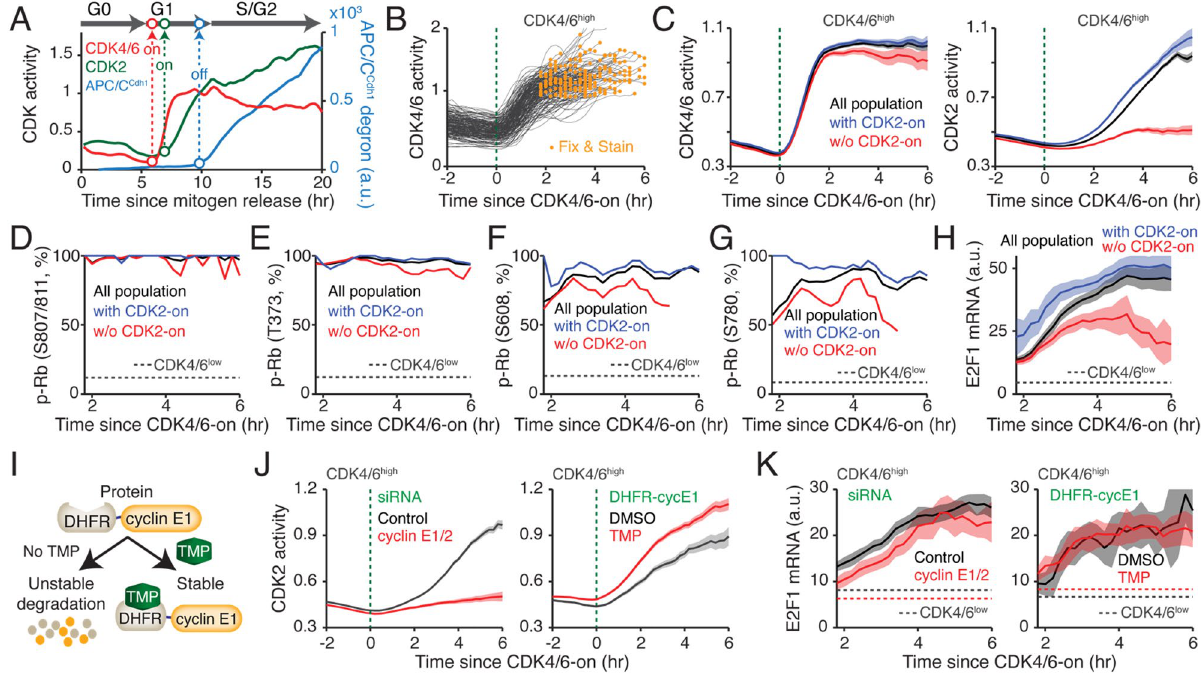
Figure 3. CDK4/6 activation triggers Rb phosphorylation and E2F activation regardless of CDK2 activation kinetics. ( A ) Representative time course analysis of CDK4/6 and CDK2 activities and APC/C Cdh1 degron intensity. Cell-cycle phase and point of CDK activation and APC/C Cdh1 inactivation are labeled. ( B ) Single- cell traces of CDK4/6 activity aligned to the time of CDK4/6 activation in CDK4/6 high cells. To create more heterogeneity, mitogen-starved MCF-10A cells were stimulated with mitogens for various durations (9, 10, and 11 h) prior to fixation. Orange dots correspond to the fixation point. Green dotted line indicates CDK4/6 activity onset. ( C ) Averaged CDK4/6 activity traces (left) and averaged CDK2 activity traces (right) aligned to CDK4/6 activation in MCF-10A cells. Black, blue, and red lines correspond to all population, cells with CDK2 activity, and cells without CDK2 activity, respectively. Green dotted line indicates CDK4/6 activity onset. Data are mean ± 95% confidence interval (All population, n = 1,917 cells; with CDK2 activity, n = 879 cells; w/o CDK2 activity, n = 1,038 cells). ( D ‒ G ) Percentage of p-Rb at sites S807/811 ( D ), T373 ( E ), S608 ( F ), and S780 ( G ), as a function of CDK4/6 activation in MCF-10A cells. Dotted line indicates percentage of p-Rb in CDK4/6 low cells. Black, blue, and red lines correspond to all cells, cells with CDK2 activity, and cells without CDK2 activity, respectively. ( D ) All population, n = 1,917 cells; with CDK2 activity, n = 1,038 cells; w/o CDK2 activity, n = 879 cells; CDK4/6 low cells, n = 4,127 cells. ( E ) All population, n = 825 cells; with CDK2 activity, n = 545 cells; w/o CDK2 activity, n = 280 cells; CDK4/6 low cells, n = 2,333 cells. ( F , G ) All population, n = 494 cells; with CDK2 activity, n = 332 cells; w/o CDK2 activity, n = 162 cells; CDK4/6 low cells, n = 1,253 cells. ( H ) Averaged E2F1 mRNA levels aligned to the time of CDK4/6 activation. Black, blue, and red lines correspond to all population, cells with CDK2 activity, and cells without CDK2 activity, respectively. Dotted line indicates averaged mRNA level in CDK4/6 low cells. Data are mean ± 95% confidence interval (All population, n = 1,917 cells; with CDK2 activity, n = 1,038 cells; w/o CDK2 activity, n = 879 cells; CDK4/6 low cells, n = 4,493 cells). ( I ) Schematic of TMP-induced rapid expression of cyclin E1. ( J ) Averaged CDK2 activity traces aligned to the time of CDK4/6 activation in CDK4/6 high cells. Green dotted line indicates CDK4/6 activity onset. Data are mean ± 95% confidence interval (siRNA: Control, n = 3,172 cells; cyclin E1/2, n = 1,042 cells; DHFR-cyclin E1: DMSO, n = 470 cells; TMP, n = 932 cells). ( K ) Averaged E2F1 mRNA levels aligned to the time of CDK4/6 activation in CDK4/6 high cells. Dotted lines indicate the averaged E2F1 mRNA level in CDK4/6 low cells for each treatment. Data are mean ± 95% confidence interval (siRNA: Control, n = 1,699 cells; cyclin E1/2, n = 644 cells; DHFR- cyclin E1: DMSO, n = 233 cells; TMP, n = 552 cells). ( J , K ) Left, mitogen-starved MCF-10A cells transfected with either control (black) or cyclin E1/2 siRNA (red) were stimulated with mitogens for various durations (9, 10, and 11 h) prior to fixation. Right, mitogen-starved MCF-10A cells expressing DHFR-cyclin E1 were stimulated with mitogens for various durations (9, 10, and 11 h) together with either DMSO (black) or TMP (50 µM, red) prior to